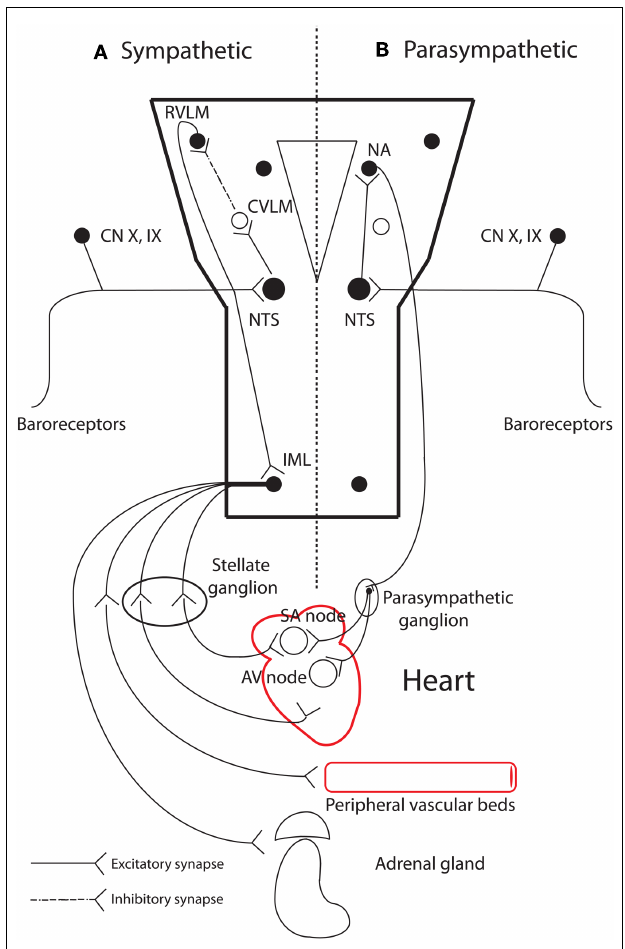
FIGURE 2 |The main peripheral and neural centers involved in autonomic cardiovascular regulation. (A) Sympathetic baroreflex arm: sensory neurons in the periphery transmit baroreceptor information via a glutamatergic synapse to the nucleus tractus solitaries (NTS) in the medulla. NTS neurons project to and excite neurons in the caudal ventrolateral medulla (CVLM). CVLM neurons in turn project and inhibit (via a GABAergic synapse) presympathetic neurons in the rostral ventrolateral medulla (RVLM). Spinally projecting presympathetic RVLM neurons make direct connections with sympathetic preganglionic neurons in the intermediolateral (IML) spinal column, which projects sympathetic outflow to effector organs. (B) Parasympathetic control of heart rate: NTS neurons receive baroreceptor and chemoreceptor information and relay via a glutamatergic pathway to the nucleus ambiguous (NA). Cardioinhibitory neurons in NA then project to the heart via the vagus nerve, which mediates its effect via muscarinic receptors in the heart. Adapted from Pilowsky and Goodchild (2002). GABA , gamma-Aminobutyric acid; SA, sinoatrial; AV,